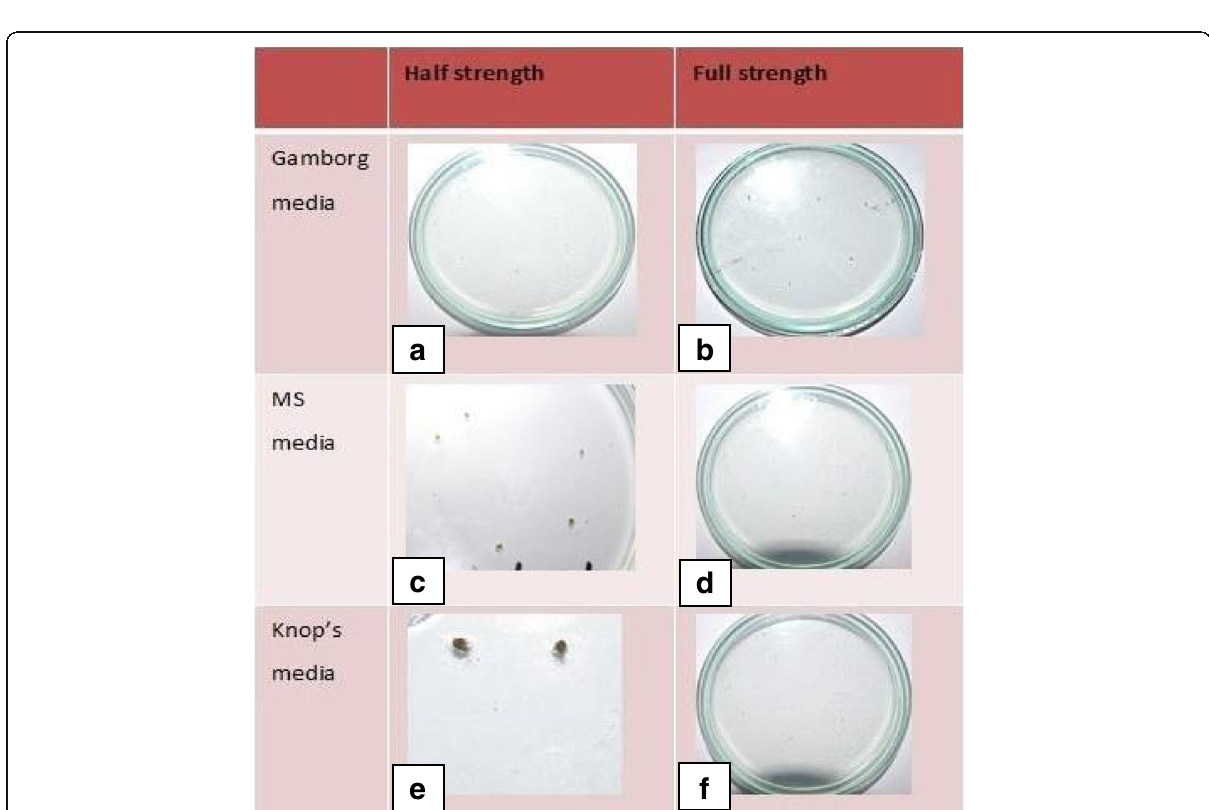
Fig. 11 Effect of different growth media on germination of gemmae. a : 0% germination of gemmae; b : 0% germination of gemmae; c : 90% germination of gemmae; d : 0% germination of gemmae; e = 20% germination of gemmae; f : 0% germination of